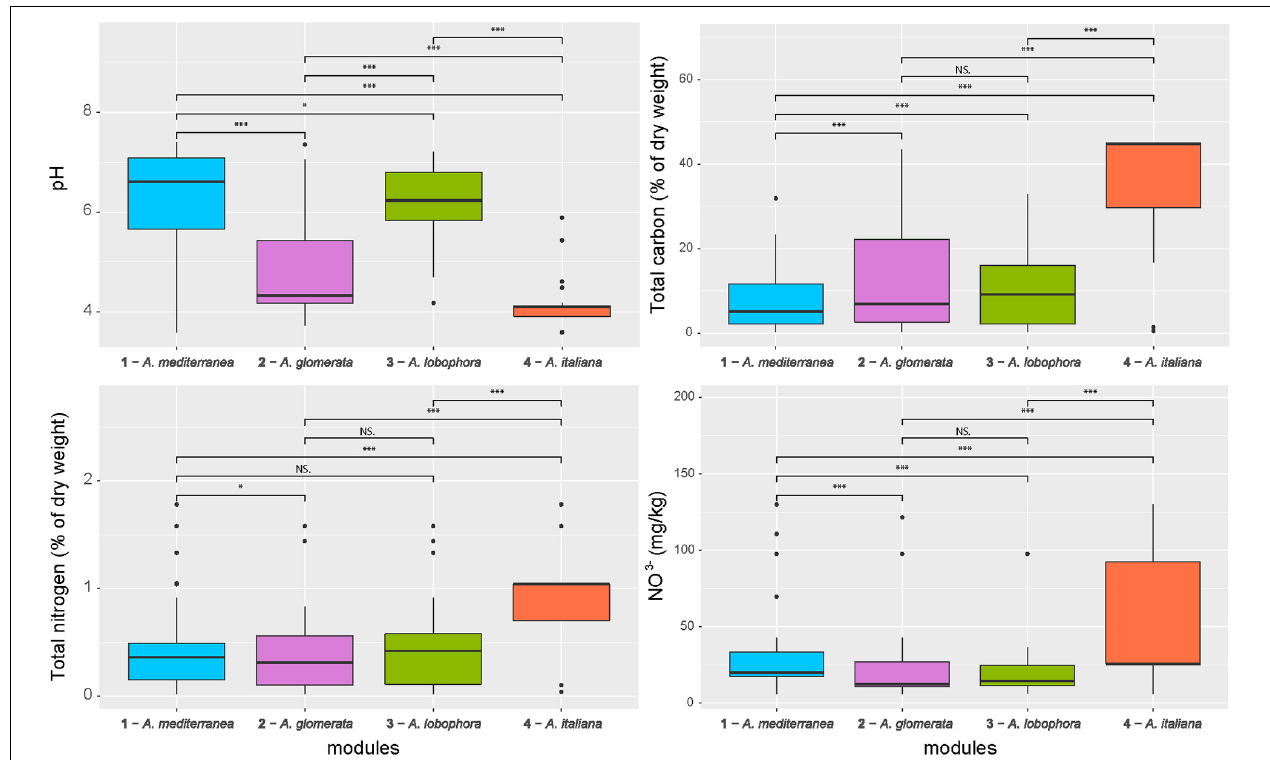
FIGURE 6 | Comparison of soil properties between the photobiont-mycobiont modules. Significance levels, calculated by Wilcoxon test, are given: “ ∗∗∗ ” – p < 0.001, “ ∗ ” – p < 0.05, “NS” – not significant. Bold lines represent the median and whiskers account for the 95% confidence interval of the data. Outliers appear as